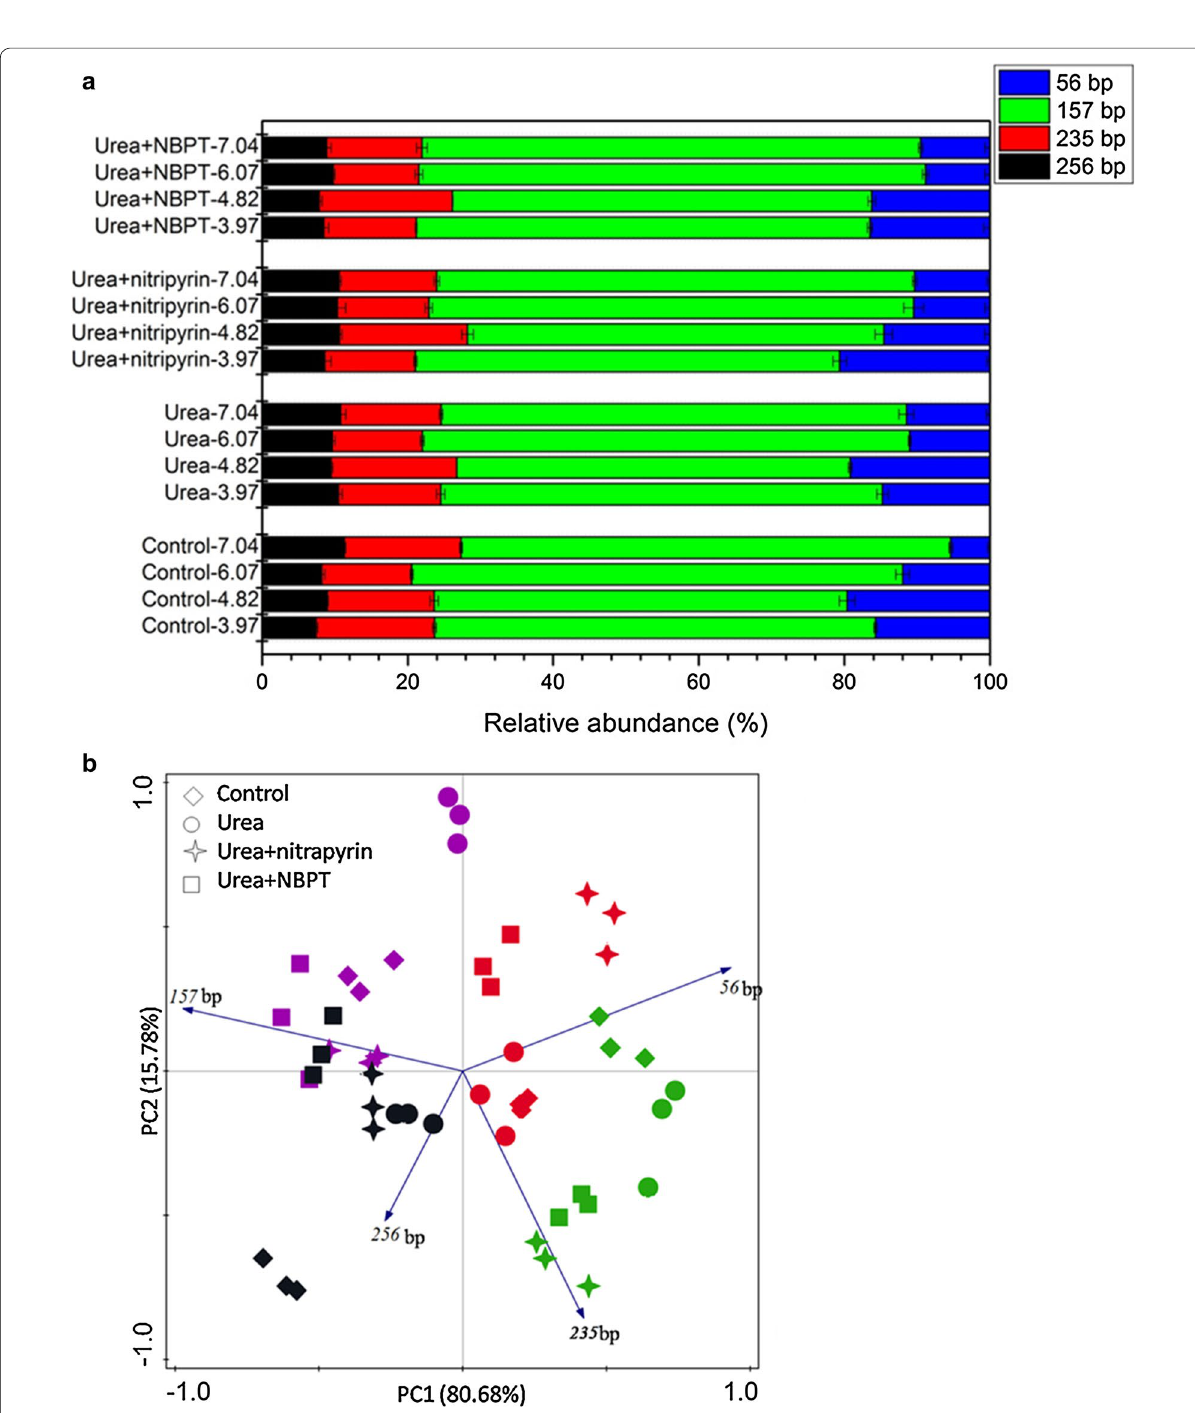
Fig. 5 Abundance ( a ) and principle component analysis ( b ) of AOB T‑RFs in vegetable soils treated with control, urea, urea NBPT at different pH. Error bars indicate standard errors of three replicates. Different pH represented by different colors, red , green , purple and black + color indicate treatments at pH 3.97, pH 4.82, pH 6.07 and pH 7.04,